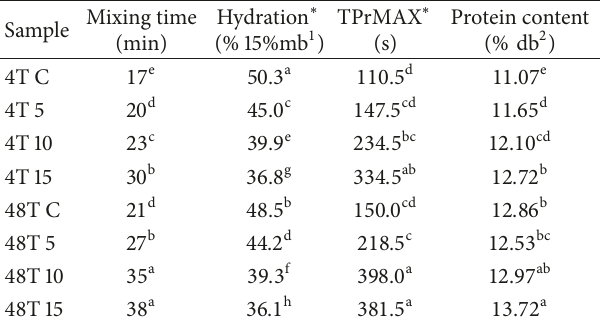
Table 3: Moisture values (%) in bread samples after baking.